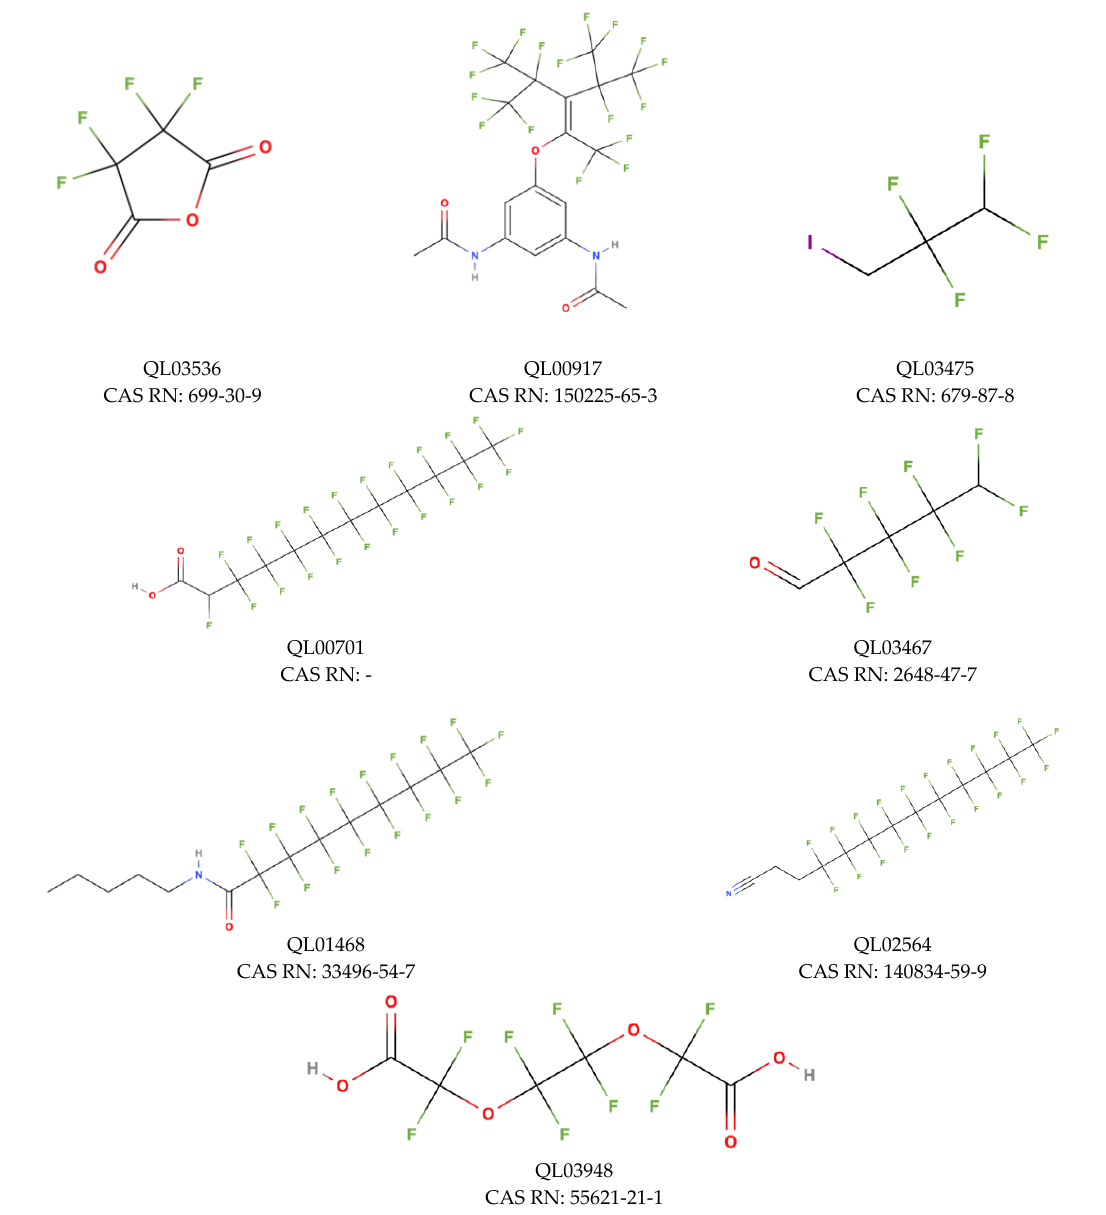
carboxylic acids (COOH-(CF2)n-CF3), S-sulfonic acids (SO3H-(CF2)n-CF3), P-phosphonic acids (PO3H2-(CF2)n-CF3, F-Fluorotelomer alcohol (F1-F7(OH-(CH2)-(CF2)n-CF3), F8-F14 (OH-(CH2)2- (CF2)n-CF3), F16 (OH-(CH2)3-(CF2)n-CF3), F17 (OH-(CH2)4-(CF2)n-CF3)), Y-dicarboxylic acids (COOH-(CF2)n-COOH). Colors: green-low binding probability, yellow-moderate binding probability, orange-moderately high binding probability ( B ); table showing binding score values for each compound shown in chart B ( C ).